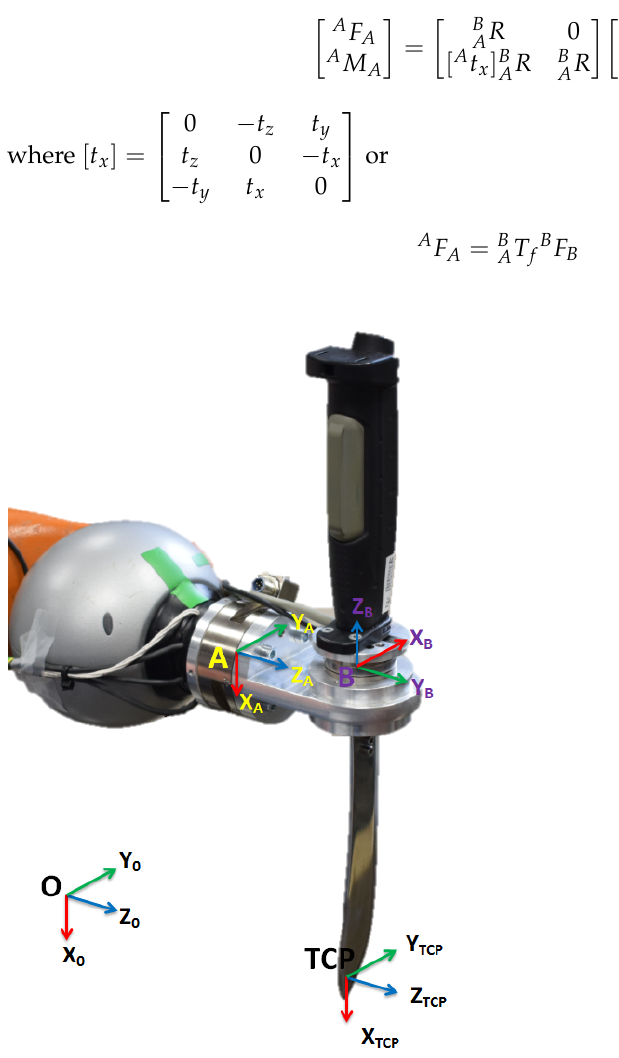
Figure 10. Visualization of all frames relating the tool -knife- with the FT sensors